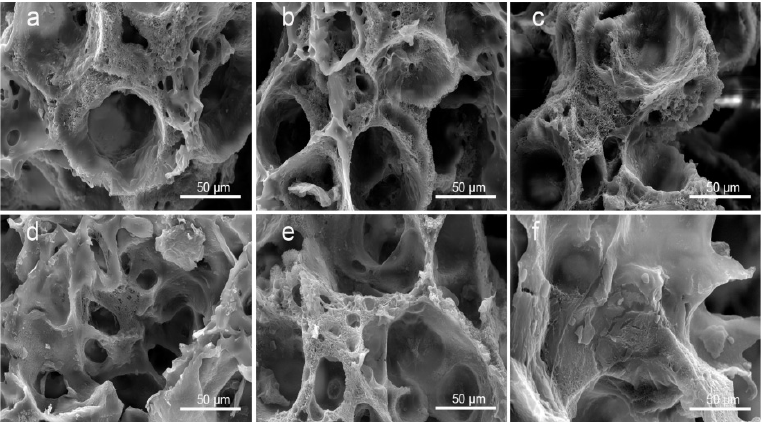
Figure 8. SEM of platelet adhesion for dual drug ‐ loaded biomimetic composite scaffolds: ( a ) S0A5,